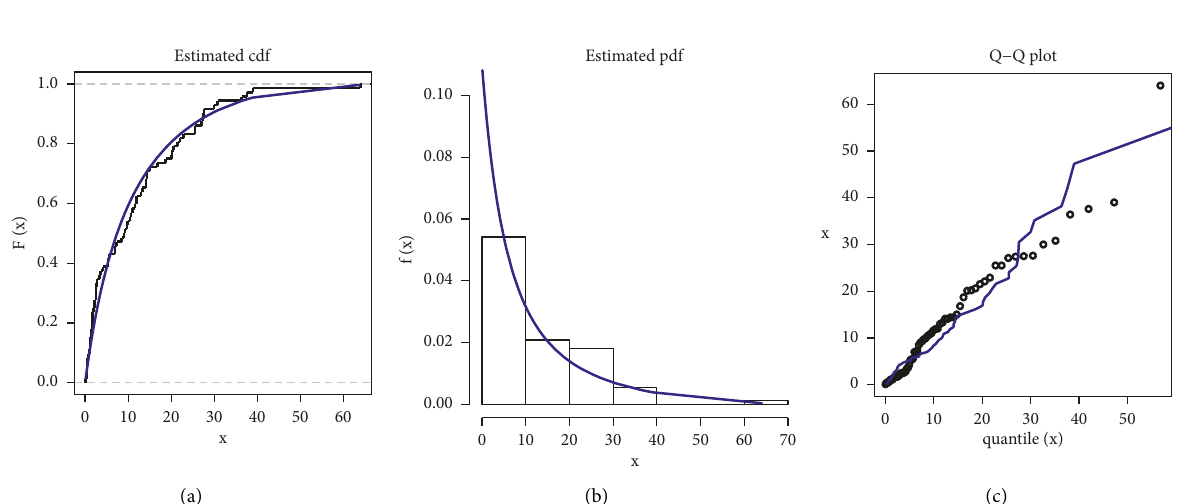
Figure 3: (a) Histogram and estimated p.d.f., (b) Estimated c.d.f. and the empirical c.d.f., (c) generate qunatile and data: flood peaks